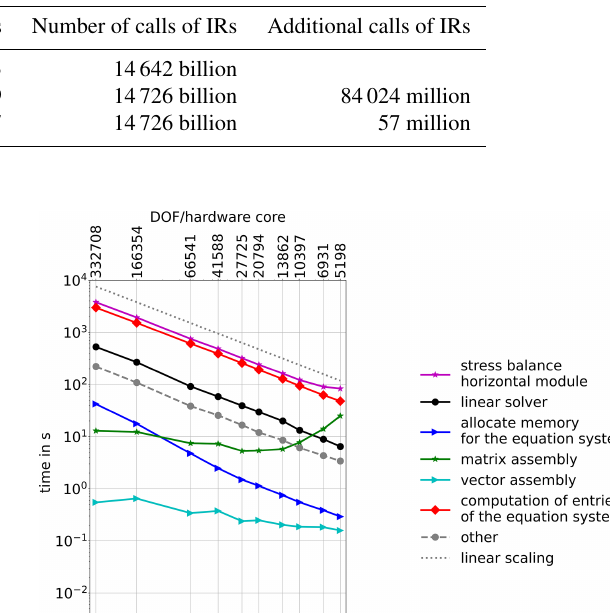
Table 2. Details of our filter, the final profile and the overhead of the measurement environment 30 time steps of G250 with 3072 MPI processes.